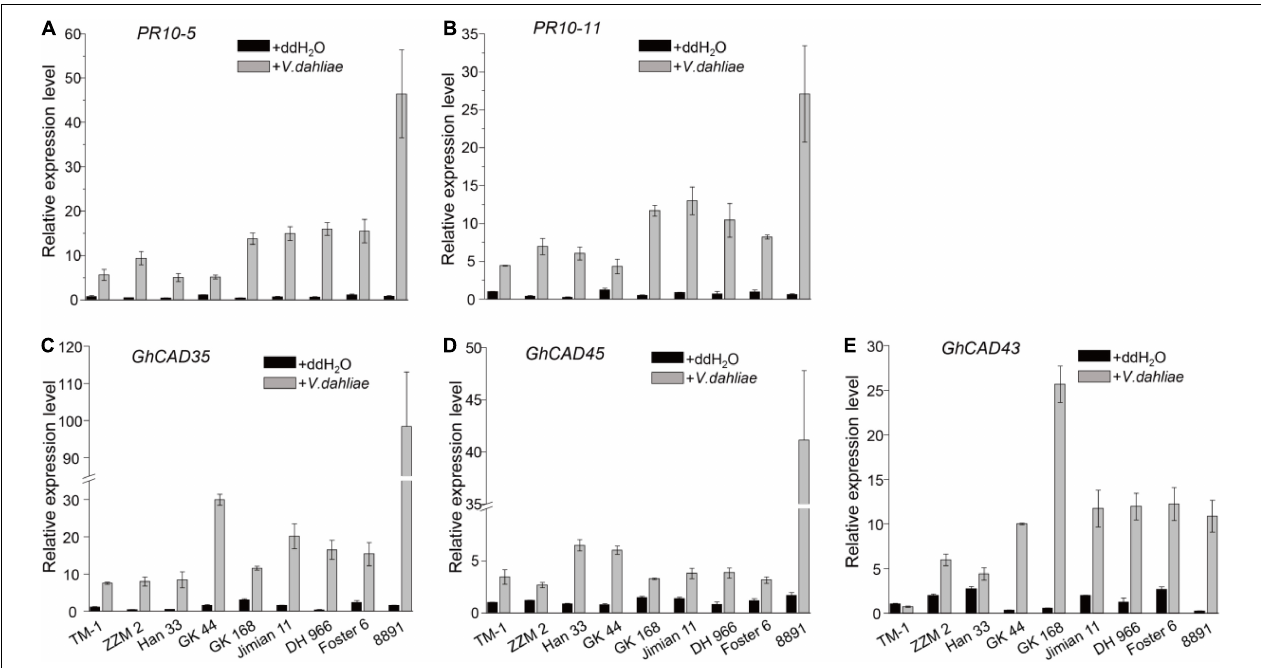
FIGURE 2 | V. dahliae inoculation induces the expression of several GhCADs in different G. hirsutum cultivars. (A,B) The transcriptional levels of two pathogen defense-related genes PR10-5 and PR10-11 under control (ddH 2 O) and V. dahliae treatment conditions in different G. hirsutum cultivars. (C–E) The transcriptional levels of GhCAD35 , GhCAD45 , GhCAD43 , and GhCAD40 under control (ddH 2 O) and V. dahliae treatment conditions in different G. hirsutum cultivars. Four Verticillium wilt resistant cultivars (ZZM 2, Han 333, GK 44, and GK168), four Verticillium wilt susceptive cultivars (Jimian 11, DH 966, Foster 6, and 8891) and TM-1 were used in the V. dahliae inoculation experiment; two-weeks-old plants 18 days after V. dahliae inoculation were used for qRT-PCR analysis. Three biological replicates were performed for each treatment. The gene expression level of each gene in TM-1 under the control (ddH 2 O) treatment was normalized as 1. GhUBQ7 was used as reference